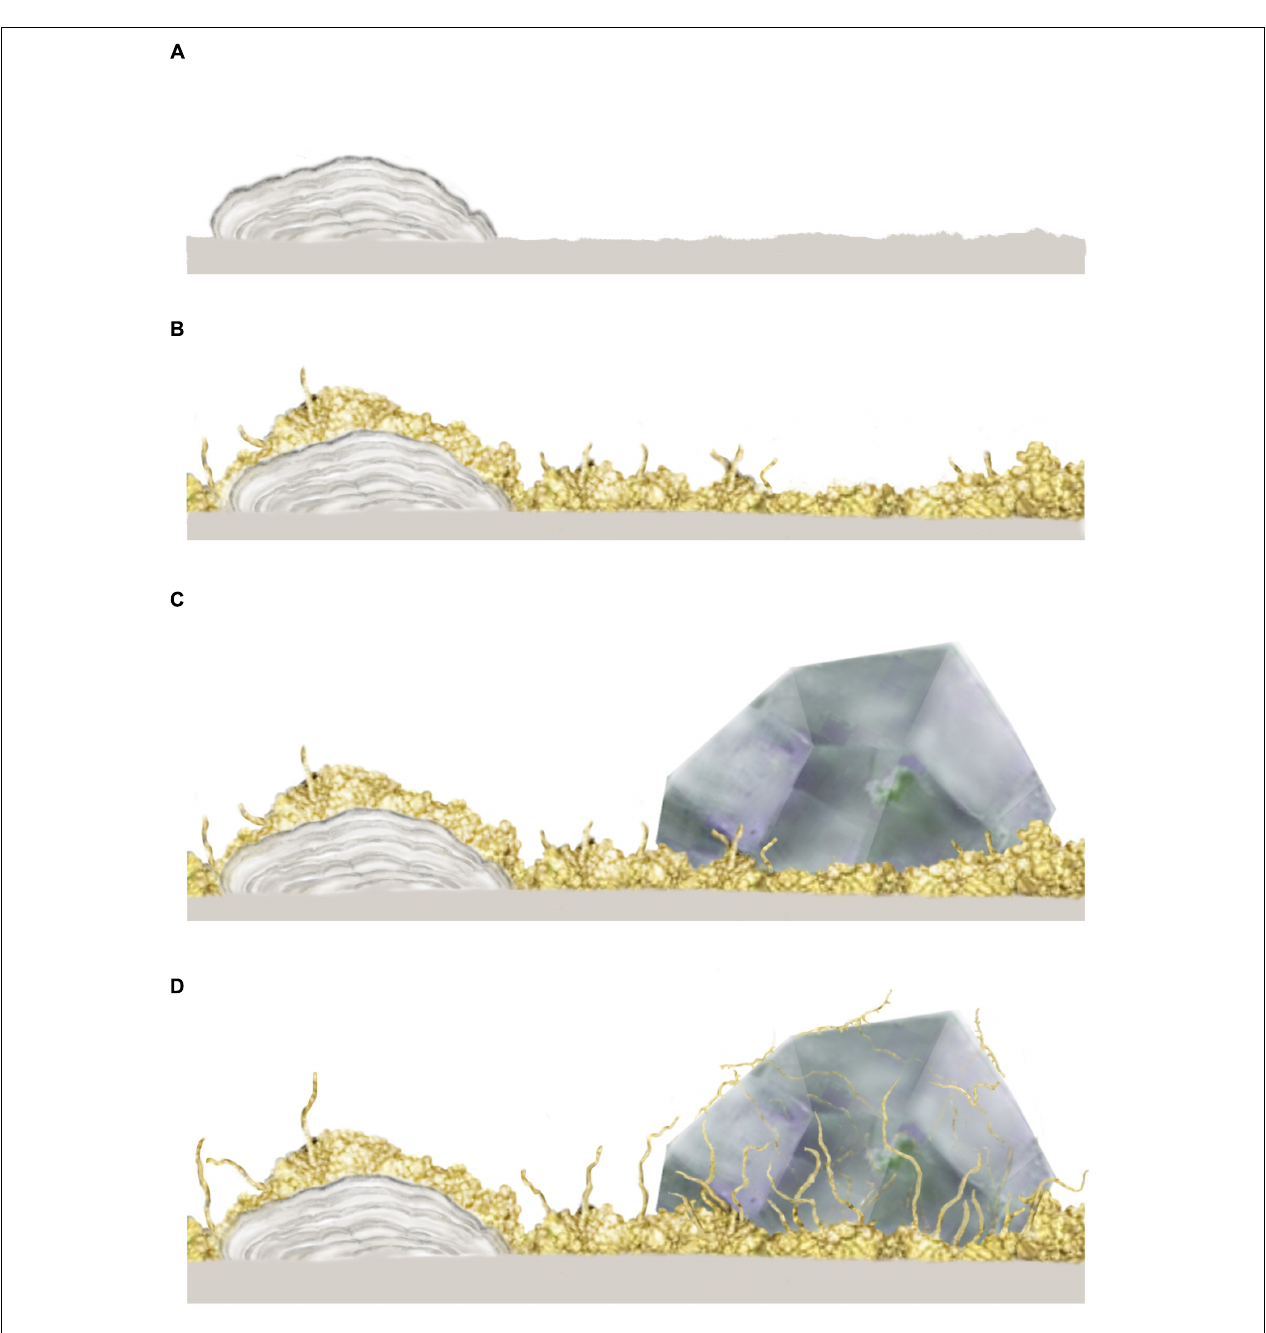
FIGURE 2 | Conceptual image from Ivarsson et al. (2015c) showing the stepwise colonization of prokaryotic and fungal biofilms in an open crack formed in subsurface pillar basalt. (A) Initial establishment of a prokaryotic biofilm, presumably consisting of iron-oxidizing prokaryotes, which form iron, manganese and silica rich laminated crusts, or microstromatolites. (B) A heterotrophic fungal biofilm is established, over the prokaryotic base film, where fungal filaments protrude and form complex mycelia within the open pore spaces. (C) Secondary minerals in the form of zeolites form within with the fungal biofilm which eventually becomes partly buried. (D) Partly buried fungal filaments bore into a zeolite crystal, presumably as a survival strategy or for trophic reasons. The copyright holder has approved re-publishing and the image is under the terms of the Creative Commons Attribution License.